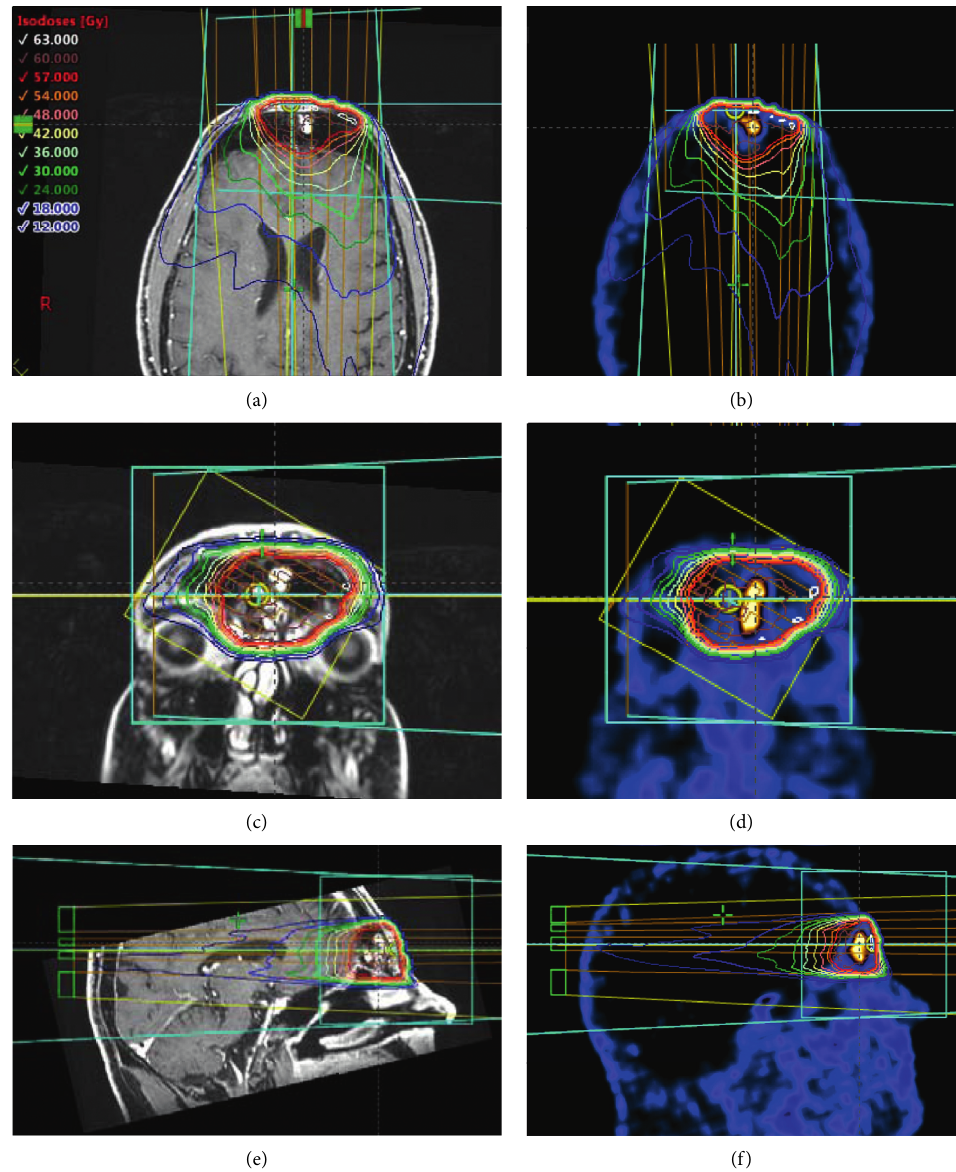
Figure 1: Dose distribution of postoperative VMAT for a multiple recurrent ossifying fibromyxoid tumor of the left frontal sinus causing TIO. Isodose lines are shown on axial (a, b), coronal (c, d), and sagittal (e, f) planes of coregistered preoperative MR (a, c, and e), 68 Ga- DOTATATE PET, and simulation CT images (b, d, and f). The red line represents the 95%